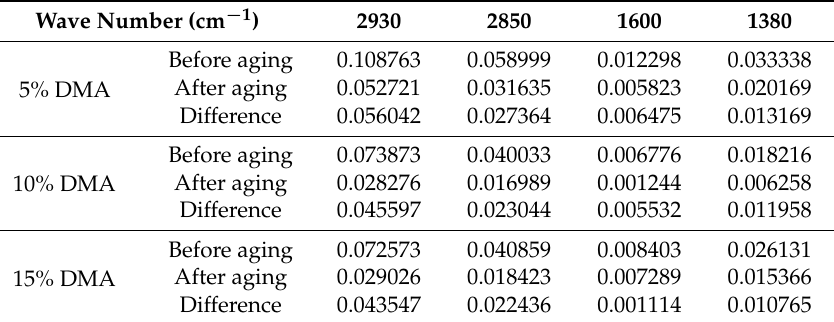
Table 6. Peak values for the featured functional groups of DMA.